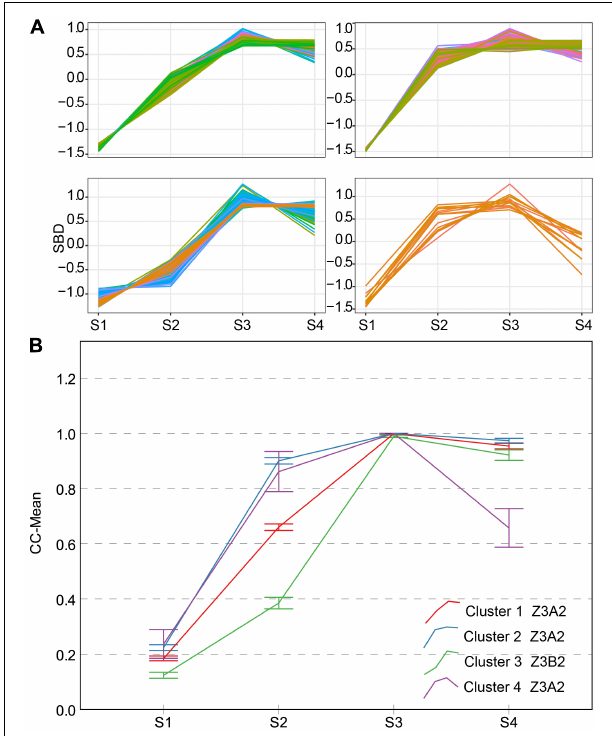
FIGURE 6 | Clustering analysis for CC time series (A) and four clusters and typical curve of CC trait (B) . (A) The horizontal X -axis represents four growth stages, and the vertical Y -axis represents the shape-based distance. (B) The horizontal X -axis represents four growth stages, and the vertical Y -axis represents the mean value of CC at a specific growth stage. Zenith point lies at the S3 growth stage and its adjacent point lies at the S2 growth stage. Typical curves are based on mean values with a 95% confidence interval. CC, canopy cover; SBD, shape-based